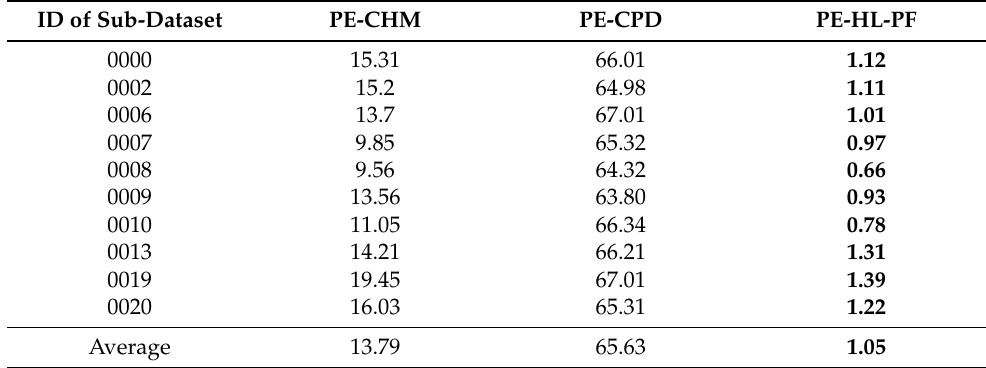
Table 5. Comparison of the mean runtime for 100 objects